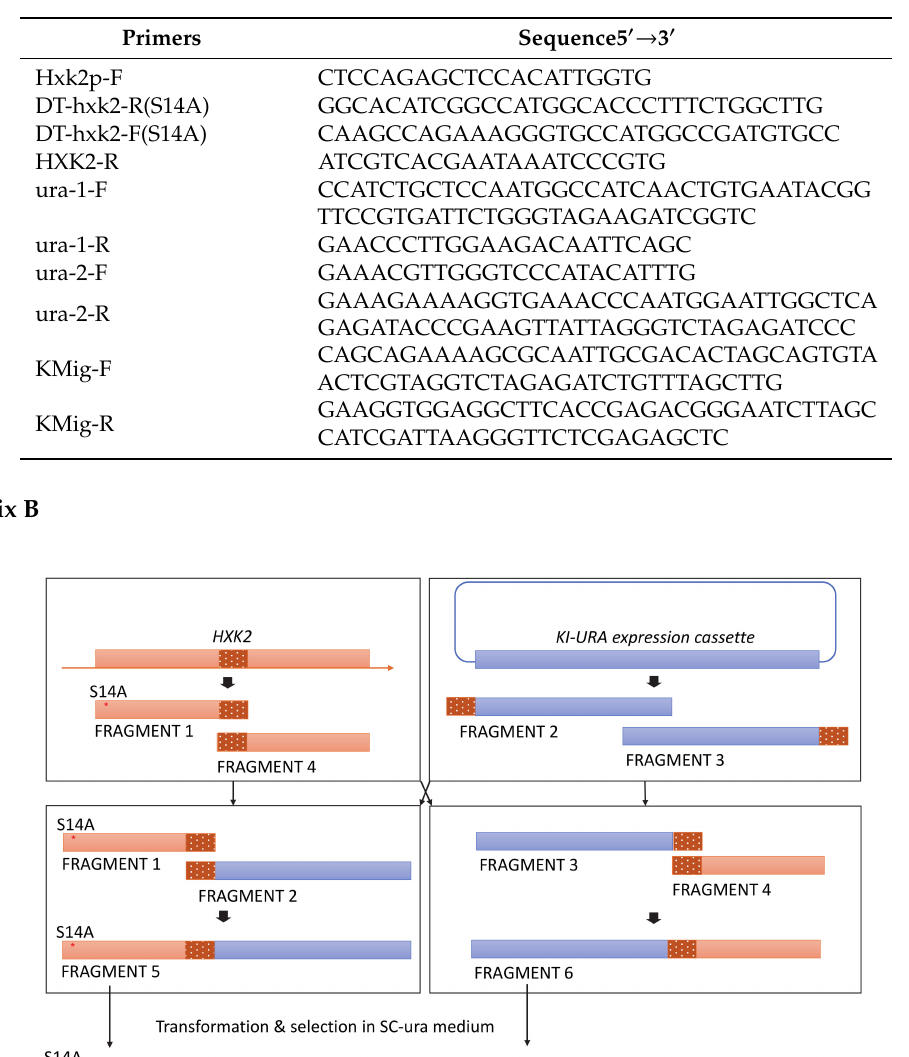
Table A1. Oligonucleotide primers used in this work.